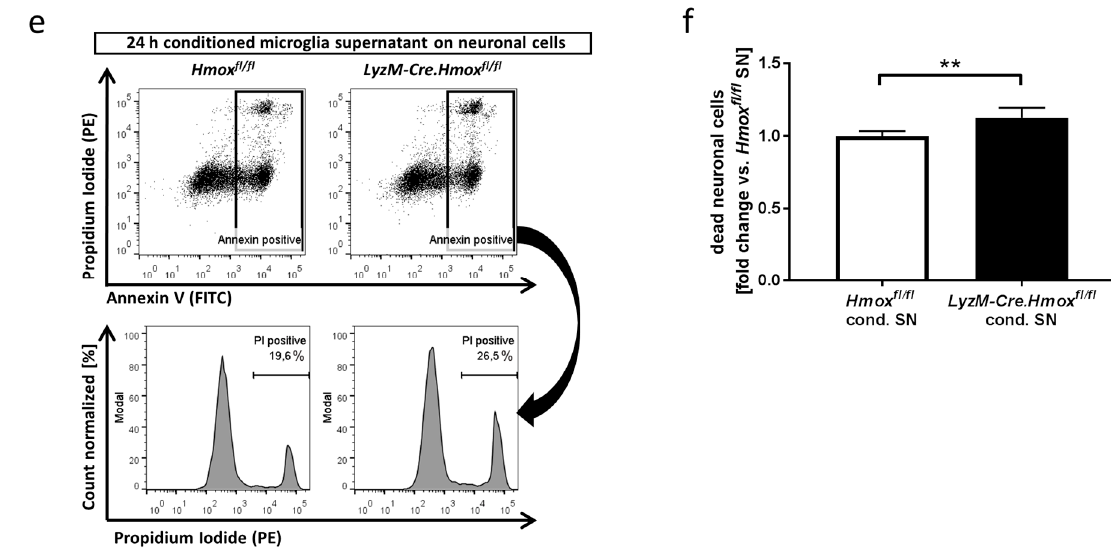
Figure 5. HO-1 dependent shift in microglial cytokine release after blood exposure. ( a ) Representative flow cytometry plots analyzing the cytokine secretion by Hmox1 fl / fl or LyzM-Cre.Hmox1 fl / fl microglia after 30 min of blood and CO exposure, Cytometric Bead Array (CBA) Mouse Inflammation Kit with IL-6, IL-10, MCP-1, IFN- γ , TNF, and IL-12p70 ( b ) Flow cytometric determination of microglial MCP-1 secretion by Hmox1 fl / fl or LyzM-Cre.Hmox1 fl / fl microglia +/ − blood and CO 250 ppm, 30 min. ** p = 0.009 for control Hmox1 fl / fl vs. LyzM-Cre.Hmox1 fl / fl , n = 3 experiments. ( c ) Representative flow cytometry plots analyzing the cytokine secretion by Hmox1 fl / fl or LyzM-Cre.Hmox1 fl / fl microglia after 1 h of blood and CO exposure. ( d ) Flow cytometry of microglial MCP-1 secretion in Hmox1 fl / fl or LyzM-Cre.Hmox1 fl / fl microglia +/ − blood and CO 250 ppm, 1 h. ** p = 0.001 for control Hmox1 fl / fl vs. LyzM-Cre.Hmox1 fl / fl , * p = 0.05 LyzM-Cre.Hmox1 fl / fl control vs. CO, n = 3 experiments. ( e , f ) E ff ect of factors released by microglia on neuronal cell death in HT22 cells in vitro analyzed by flow cytometry after annexin V / PI staining. HT22 cells were exposed to 10 µ L blood and cultivated for 24 h in 50% supernatant of cultured microglia isolated from either Hmox fl / fl or LyzM-Cre.Hmox fl / fl mice and conditioned with 10 µ L blood exposure for 1 h. (( e ) representative flow cytometry plots (cond = conditioned; SN = supernatant; PI = propidium iodide; propidium iodide (PI) was detected in the PE channel and annexin V in the FITC channel); ( f ) quantification as fold change vs. Hmox fl / fl from total of n = 6 experiments; dead neuronal cells = annexin V and PI-positive cells; ** p = 0.0026).